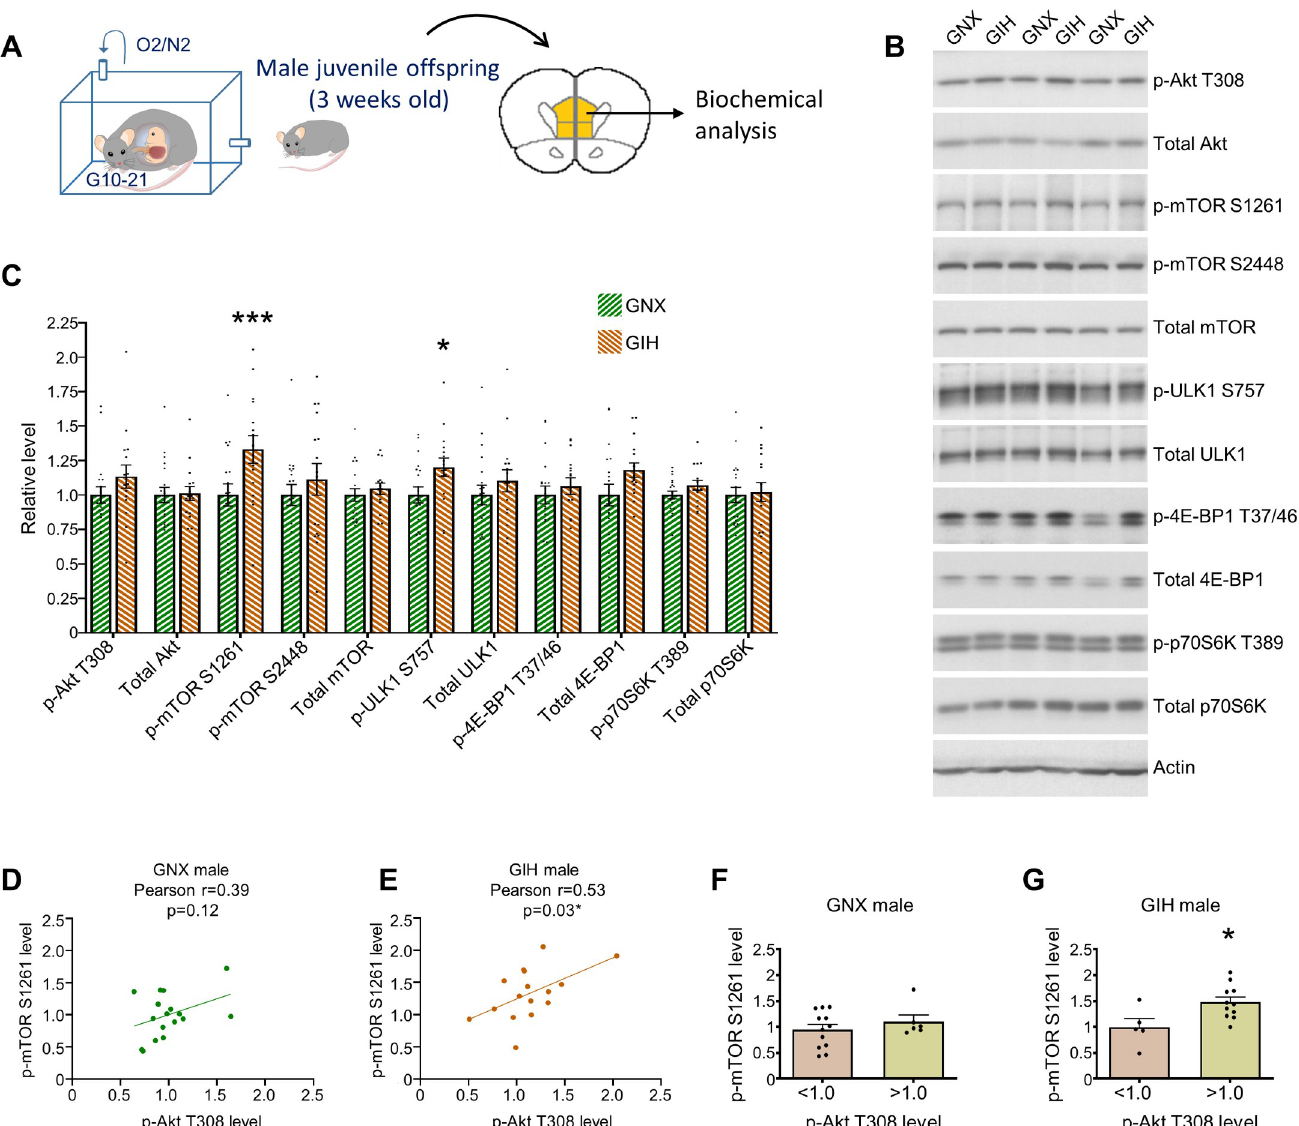
Fig 8. Biochemical analysis of mPFC homogenates in 3-week-old male offspring. (A) Schematic depicting age of GNX and GIH male offspring used for biochemical analysis of mPFC homogenates. (B) Representative western blots showing indicated phospho or total proteins in 3-week-old GNX and GIH male offspring mPFC homogenates. (C) Quantification of indicated phospho and total protein levels in 3-week-old GNX and GIH male offspring mPFC homogenates (normalized to actin). One-way ANOVA with Fisher LSD: p-Akt 308 ( p = 0.1614), total Akt ( p = 0.9063), p-mTOR S1261 ( ��� p = 0.0007), p-mTOR S2448 ( p = 0.2364), total mTOR ( p = 0.6305), p-ULK1 S757 ( � p = 0.0354), total ULK1 ( p = 0.2784), p-4E-BP1 T37/46 ( p = 0.4951), total 4E-BP1 ( p = 0.0586), p-p70S6K T389 ( p = 0.4579), total p70S6K ( p = 0.8239). n = 19 GNX and 16 GIH. (D) Correlation analysis performed in mPFC homogenates from 3-week-old GNX male offspring. p-Akt T308 levels did not significantly correlate with levels of p-mTOR S1261. Statistics indicated above graph. (E) Correlation analysis performed in mPFC homogenates from 3-week-old GIH male offspring. p-Akt T308 levels significantly correlated with levels of p-mTOR S1261. Statistics indicated above graph. (F) Binning of p-Akt T308 levels in 3-week-old GNX male offspring homogenates. Average GNX offspring p-Akt T308 levels are 1.0, and data split into 2 groups— samples with p-Akt T308 levels below the mean level for GNX offspring ( < 1.0) and samples with p-Akt T308 levels above the mean level for GNX offspring ( > 1.0). Levels of p-mTOR S1261 in the below and above average p-Akt T308 groups are shown. Above average p-Akt T308 levels did not result in greater levels of p-mTOR S1261 compared to samples with below average p-Akt T308 levels [t(16) = 0.9259; p = 0.3682]. (G) Binning of p-Akt T308 levels in 3-week-old GIH male offspring homogenates. GIH offspring p-Akt T308 levels were binned into 2 groups as described in (F)—those below the 1.0 mean for GNX ( < 1.0) and those above the 1.0 mean for GNX ( > 1.0). GIH offspring samples with p-Akt T308 levels greater than the mean of GNX offspring have significantly higher levels of p-mTOR S1261 than GIH offspring samples with p-Akt T308 levels below the mean for GNX offspring [t(14) = 2.646; p = 0.0192]. All bar graphs are the mean + SEM. The data underlying this figure can be found in S1 Raw Data. GIH, gestational intermittent hypoxia; GNX, gestational normoxia; LSD, least significant difference; mPFC, medial prefrontal cortex; mTOR, mammalian target of